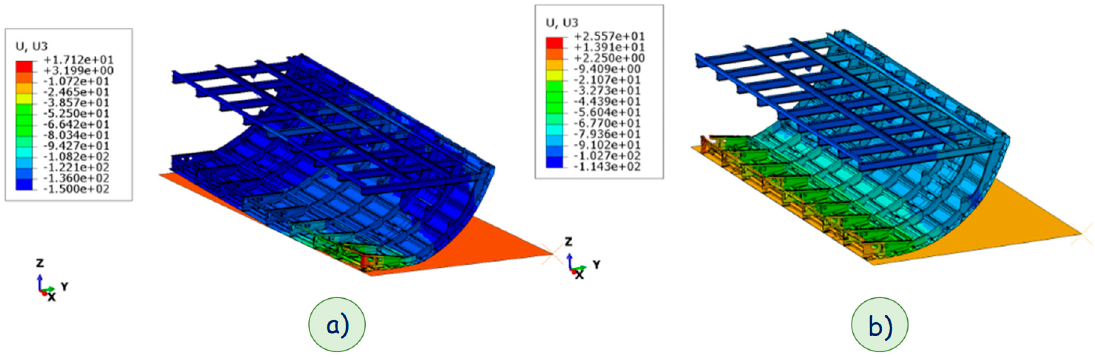
Figure 11. Initial phases of sub-cargo area impact: ( a ) 3° impact angle; ( b ) normal angle (units in mm).